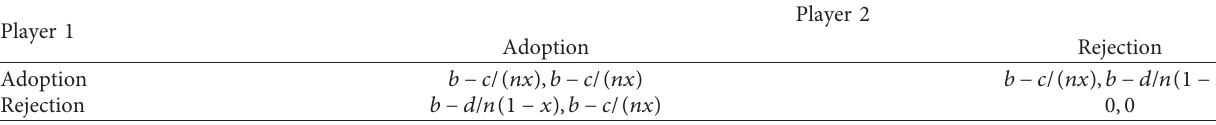
Table 1: Interactive behavioral game payoff matrix with penalty